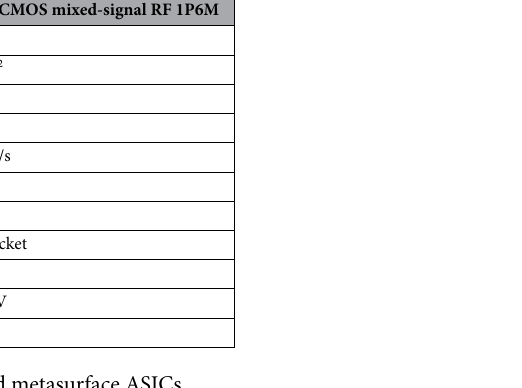
Table 1. Characteristics for the proposed metasurface